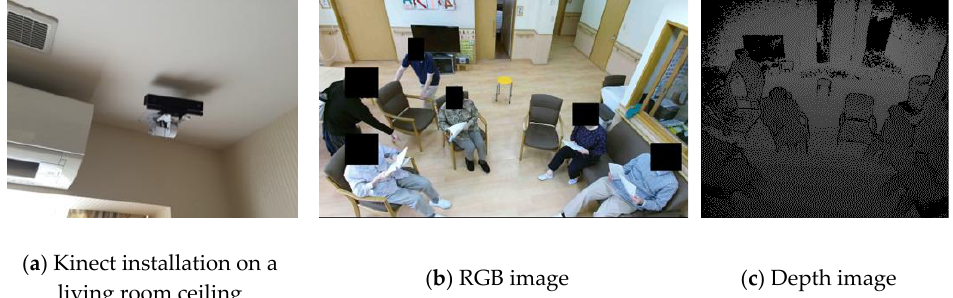
Figure 1. Example of installation of Kinect in a living room in a nursing home and captured RGB and depth image.